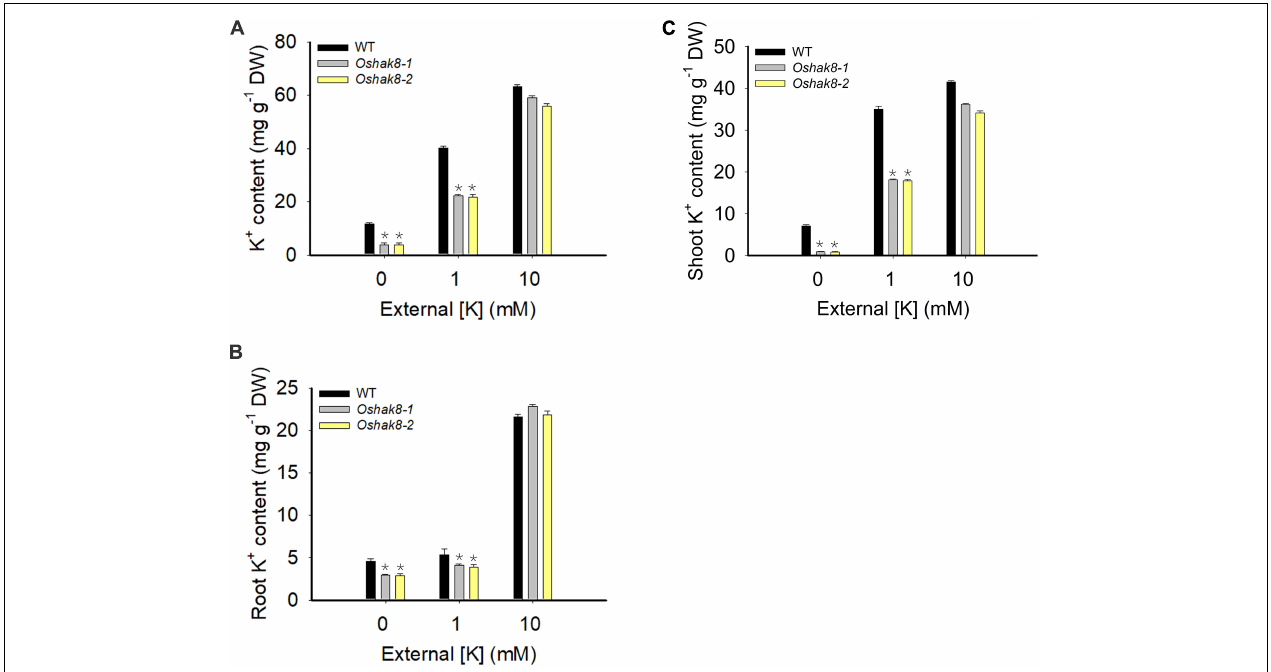
FIGURE 2 | Growth retardation of the Oshak8 mutants under K + -deficient conditions. The seeds of the wild-type plants (WT) and Oshak8 mutants ( Oshak8-1 , Oshak8-2 ) germinated in water for 5 days, then grown in hydroponic solutions containing 0, 1, or 10 mM of K + for 14 days. The whole plants, roots, and shoots were collected for K + content measurements using inductively coupled plasma analysis. (A) K + contents of WT and Oshak8 mutant ( Oshak8 -1, Oshak8 -2) plants. (B) K + contents in the roots of WT and Oshak8 mutant ( Oshak8 -1, Oshak8 -2) plants. (C) K + contents in the shoots of WT and Oshak8 mutant ( Oshak8 -1, Oshak8 -2) plants. Significant differences were found between WT and Oshak8 mutant plants ( Oshak8-1 , Oshak8-2 ) (* P < 0.01 by Student’s t -test). Data are means of three replicates of one experiment. The experiment was repeated three times with similar results. Error bars represent ± SD. Asterisks represent significant